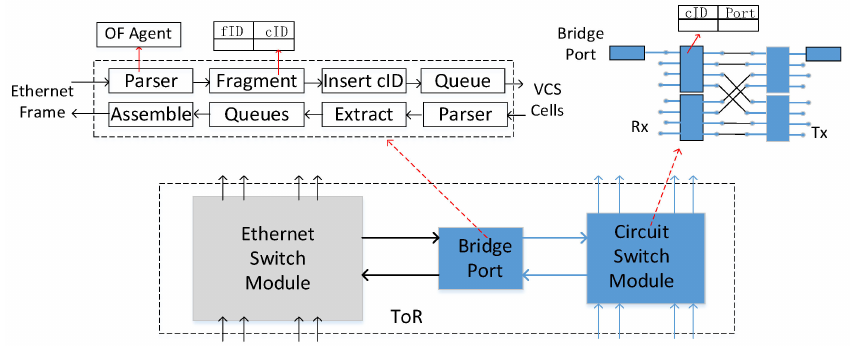
Figure 10. Implementation of VCS